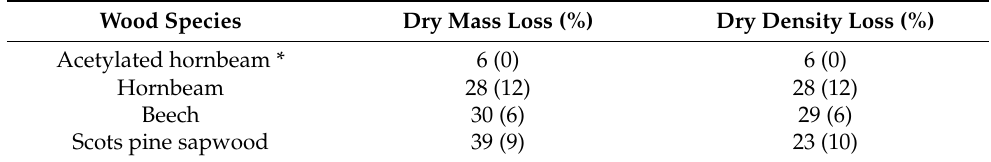
Table 3. Summary of results of field soil trial: dry mass and dry density loss of tested wood species after 6 years. Average values are presented with standard deviation in brackets.